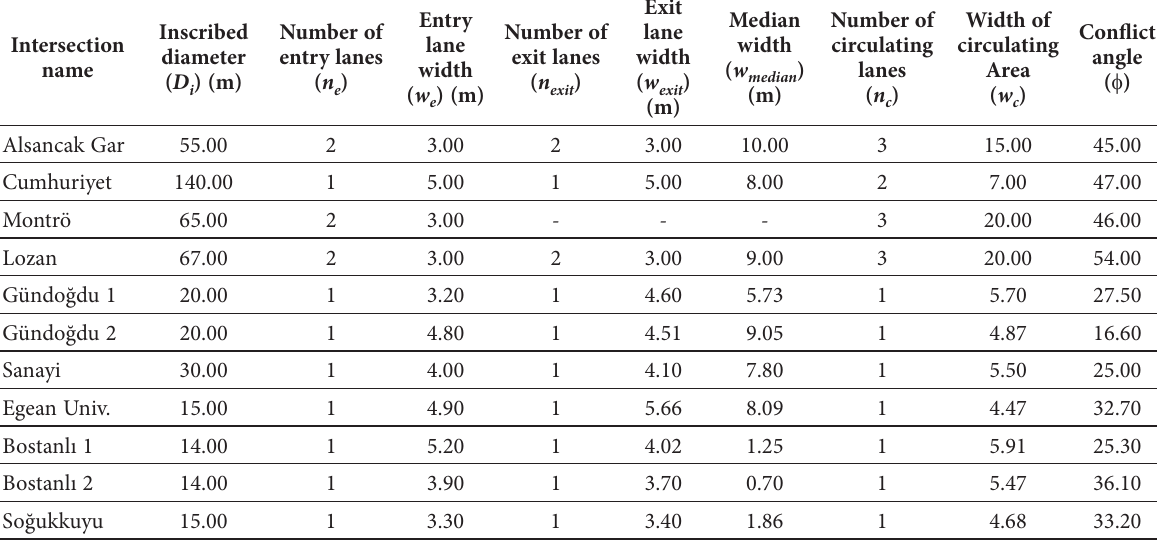
Table 1. Geometric variables of the observed traffi c circle